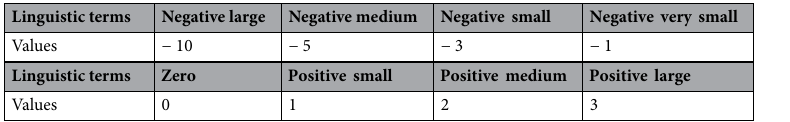
Table 10. Referential values of flow